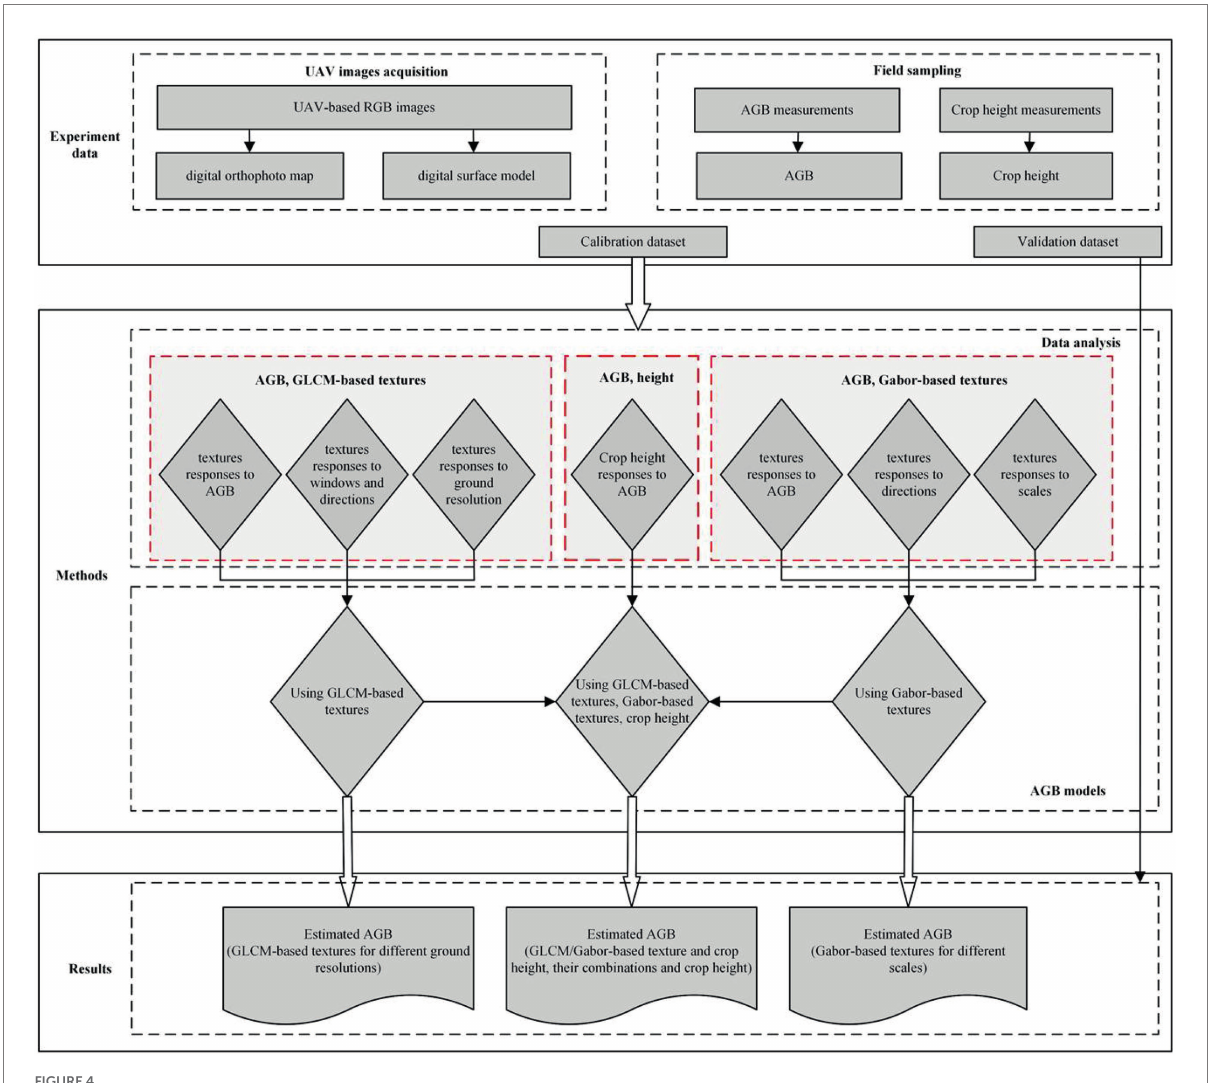
FIGURE 4 Technical route of the